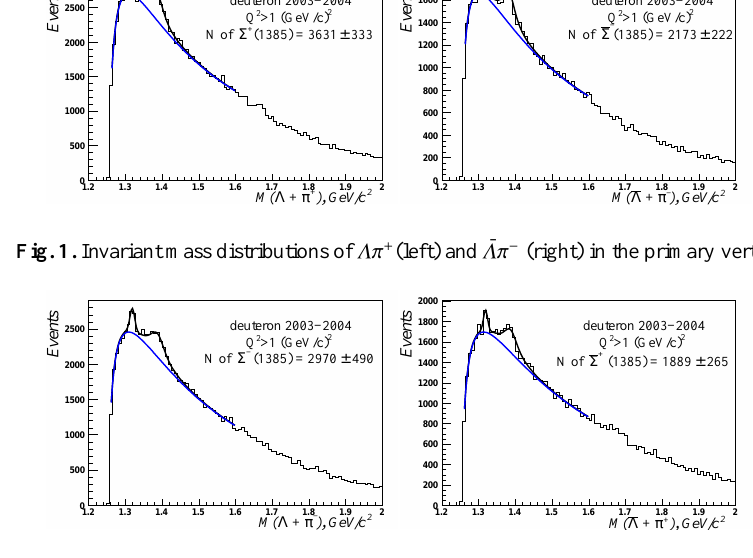
Fig. 2. Invariant mass distributions of Λπ − (left) and ¯ Λπ + (right) in the primary vertex.